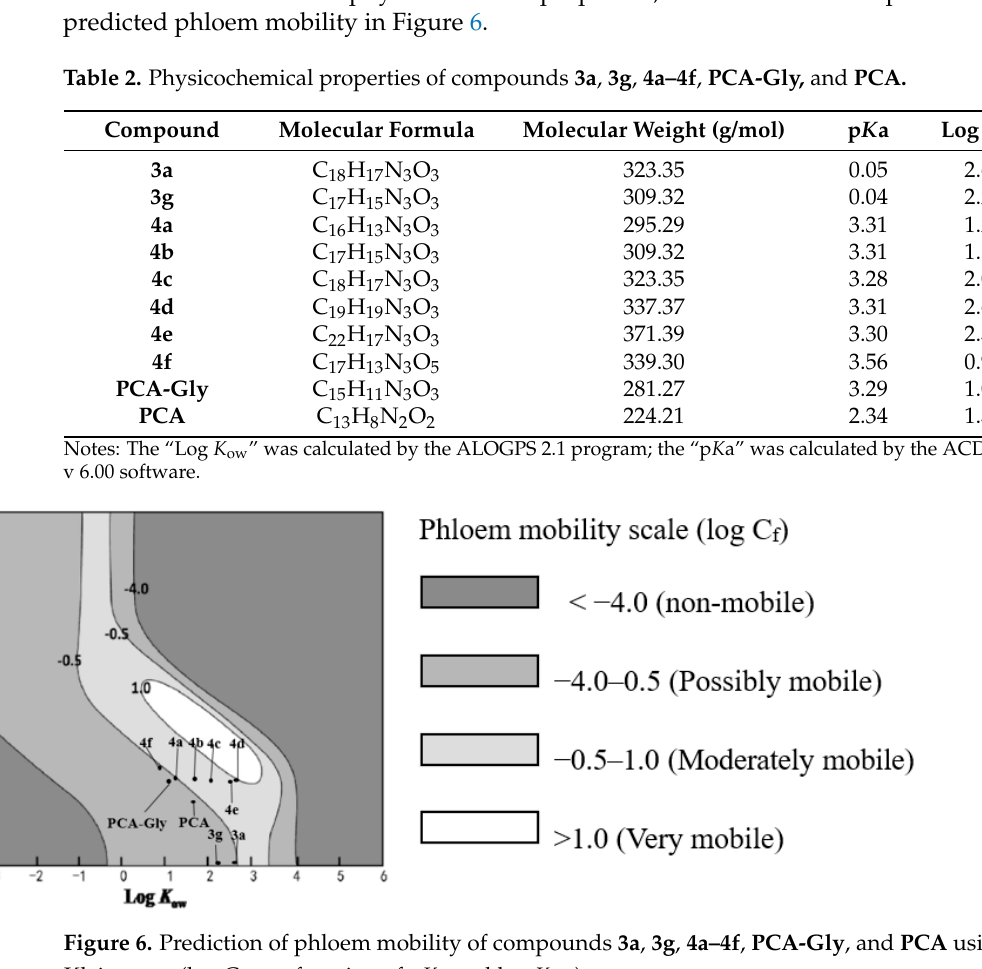
Table 3. Contents of compound 4c in the root of castor plant by different treatment.